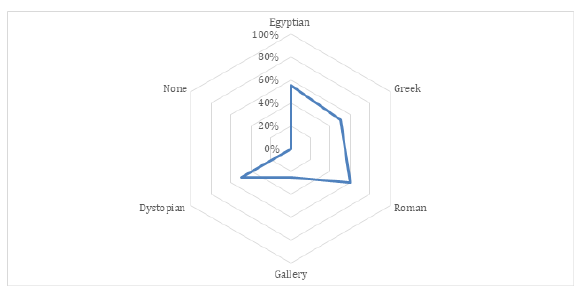
Figure 15. Evaluation graphic: which section did you prefer? The whole sample agreed that the experience provided them with new knowledge, compared to 86% in the previous